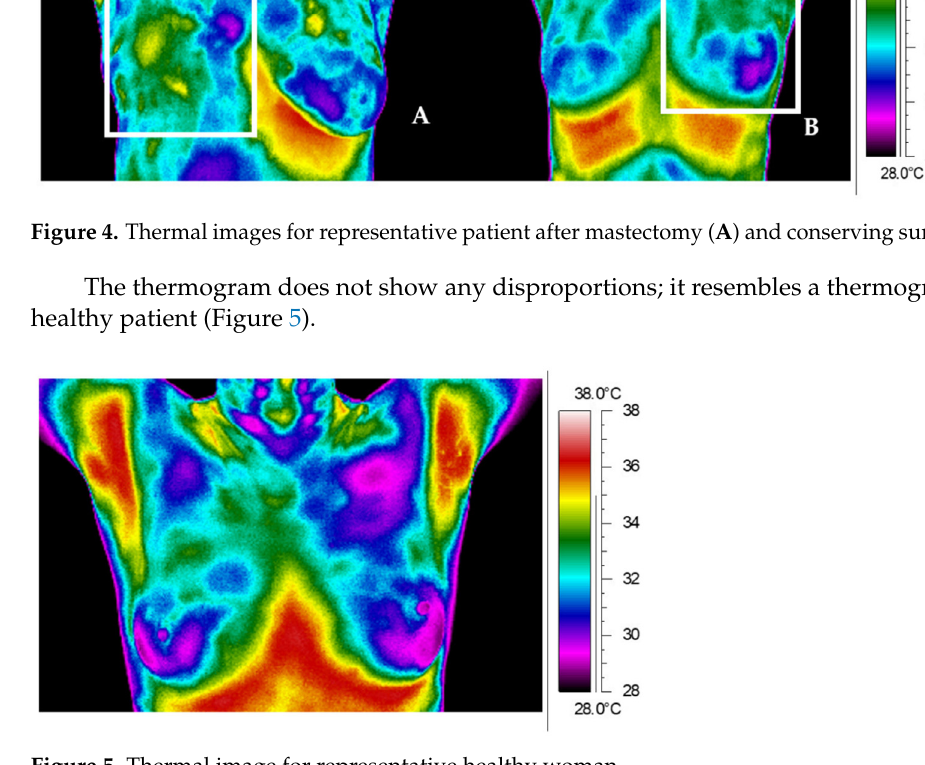
Figure 5. Thermal image for representative healthy woman.